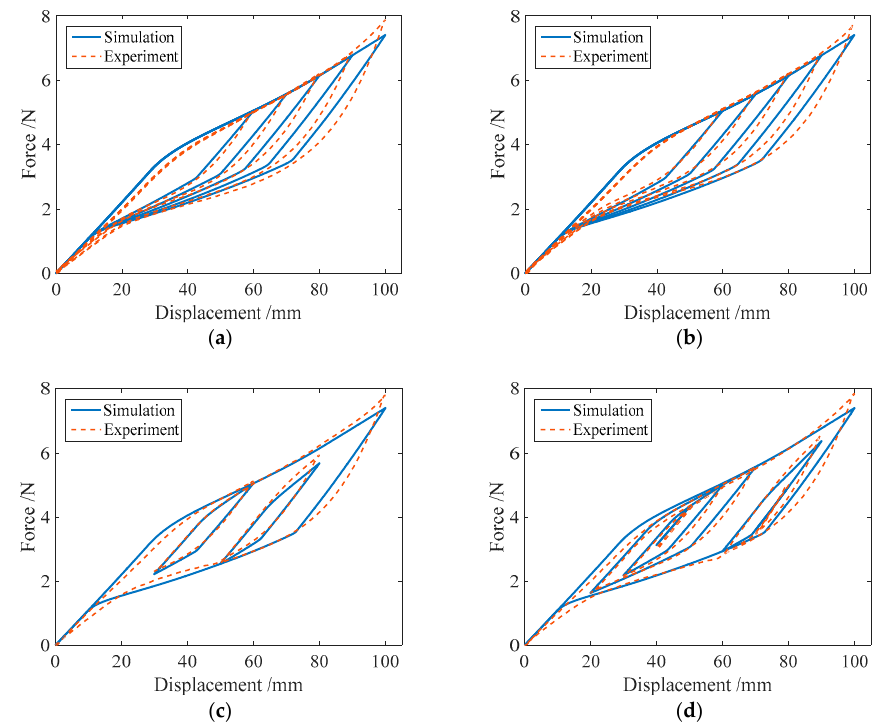
Figure 12. Simulation results of the force-displacement relationship of specimen SMA-S2 in different loading cases: ( a ) Case I; ( b ) Case II; ( c ) Case III; ( d ) Case IV.